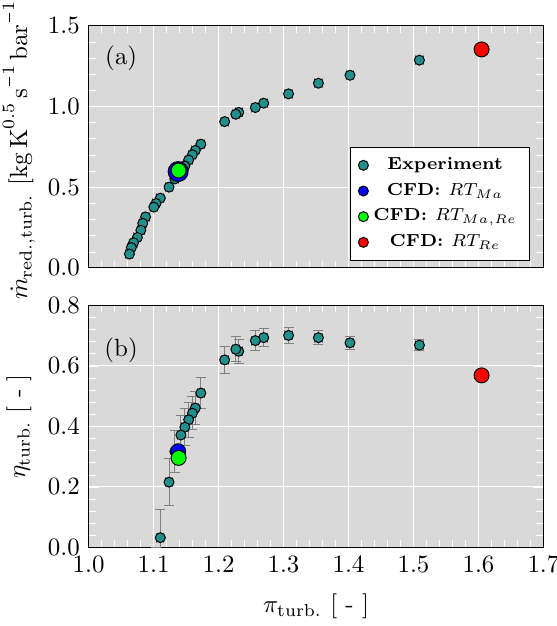
Figure 3. Turbine reduced mass flow map ( a ) and turbine efficiency map ( b ) with the selected operating point at 80% VGT opening and at 3890 rpm/K 0.5